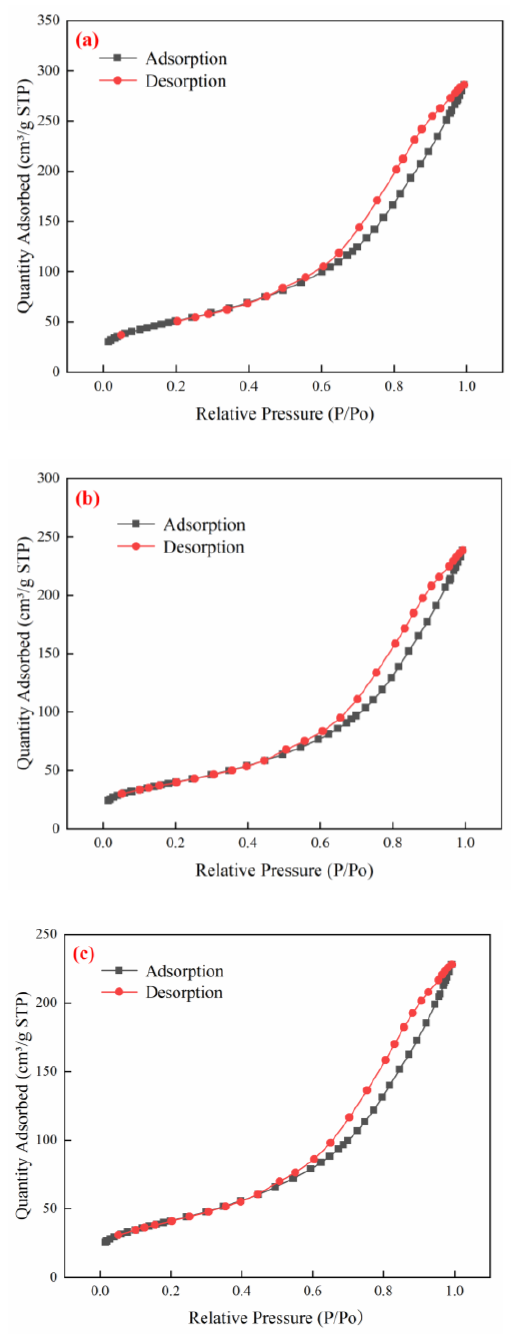
Figure 4. Adsorption and desorption isotherms of Cu- Ce@γ -Al 2 O 3 catalyst: ( a ) γ -Al 2 O 3 , ( b ) Cu- Ce@γ -Al 2 O 3 , ( c ) Cu- Ce@γ -Al 2 O 3 after utilization 30 times. ( c ) Cu-Ce@ γ -Al 2 O 3 after utilization 30